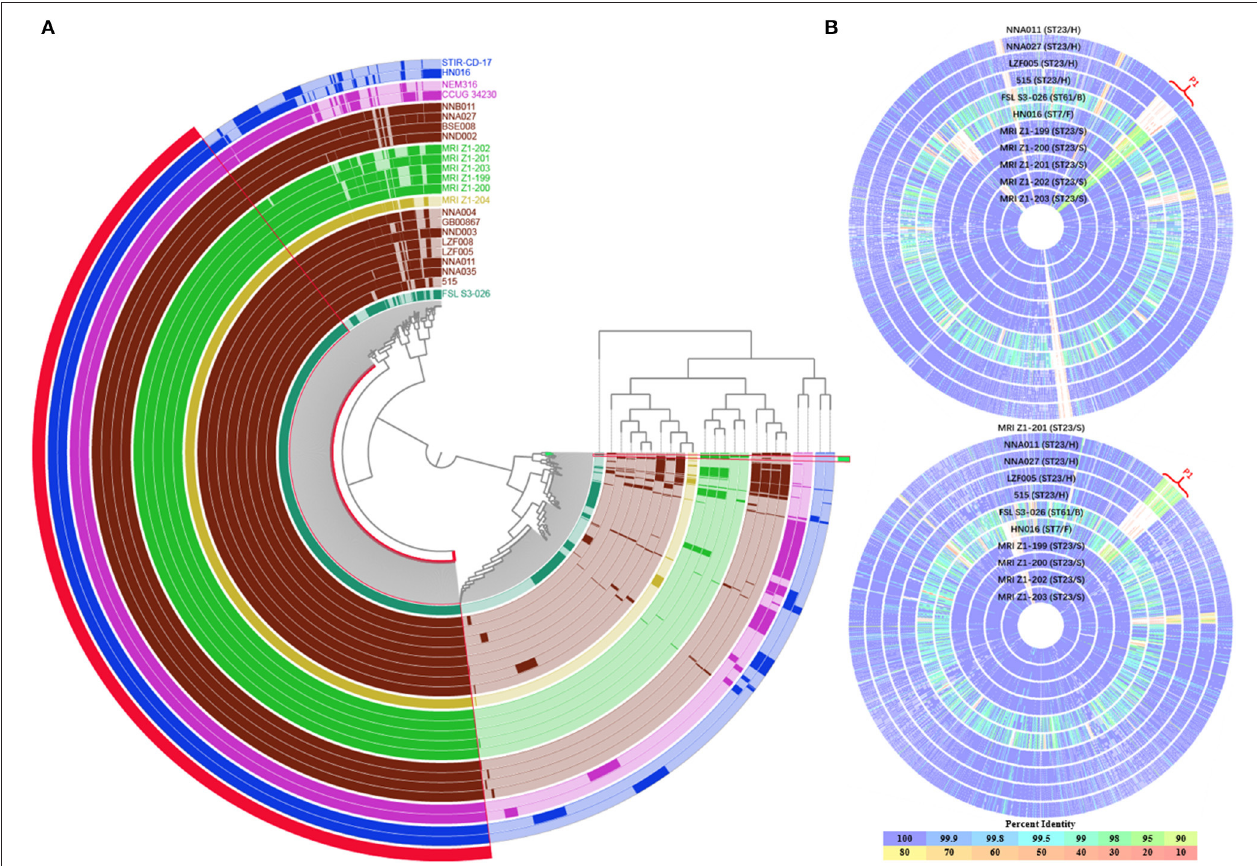
FIGURE 4 | Comparison of GBS genomes. (A) Anvi’o pangenome visualization of 23 GBS genomes. The outer in red, showed the core genome of GBS, protein clusters shared among all the strains. The outer in green, showed the protein clusters shared among seal- and bovine-derived strains (P1 in B) . The genomes were clustered based on the presence/absence pattern of protein clusters. Human Ia ST23 strains were highlighted in brown, seal Ia ST23 strains were highlighted in green, fish strains were highlighted in blue, bovine strain FSL S3-026 was highlighted in turquoise. (B) Comparison of genomes of 11 GBS strains. The H021 genome and the MRI Z1-201 genome were served as the reference respectively, and other genomes were aligned; the alignment and the figure were created by the SEED Viewer; each circle represented a different genome, the strain name was labeled on each circle. The circle correlated to reference genome was not shown; the color bar on the bottom indicated the percentage of protein sequence identity against the reference genome. H, S, B, F, and D indicated human, seal, bovine, fish, and dog,